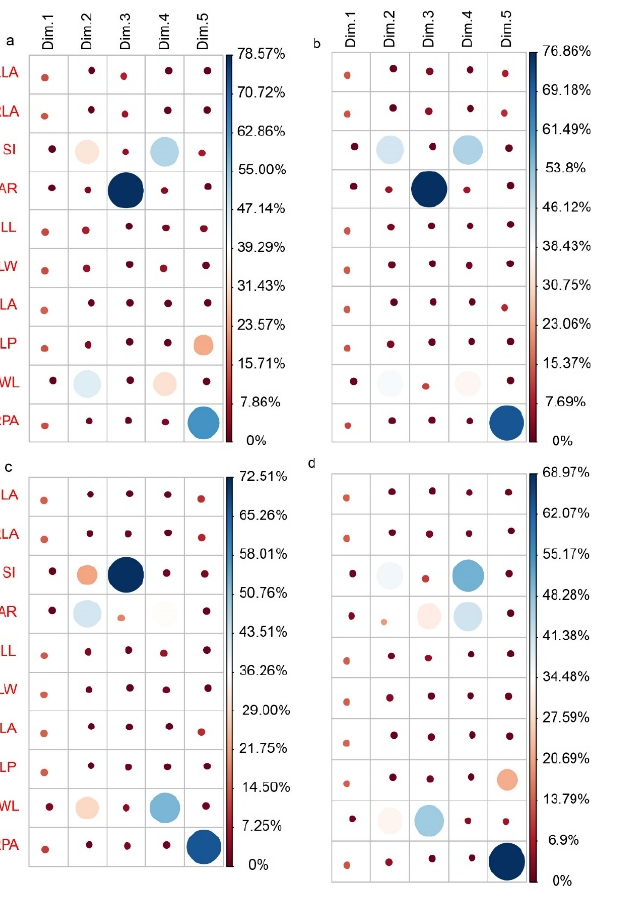
Figure 6. Contribution rate of 10 leaf phenotypic variables to principal components. ( a ): Q. acutis- sima ; ( b ): Q. variabilis ; ( c ): Q. fabri ; ( d ): Q. serrata var. brevipetiolata